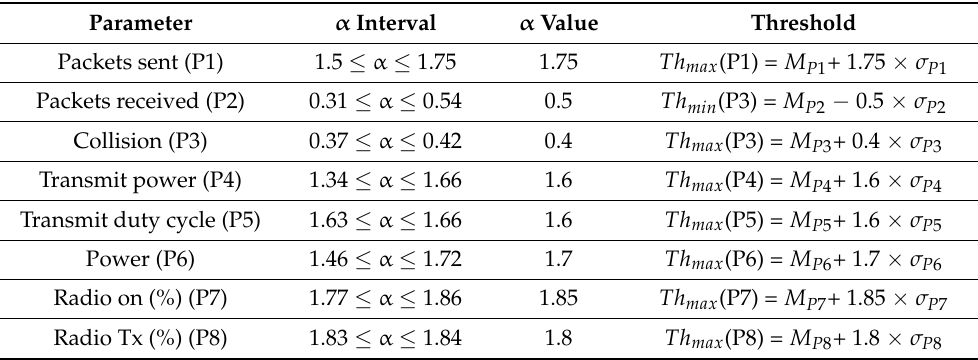
Table 4. The thresholds appropriate to each